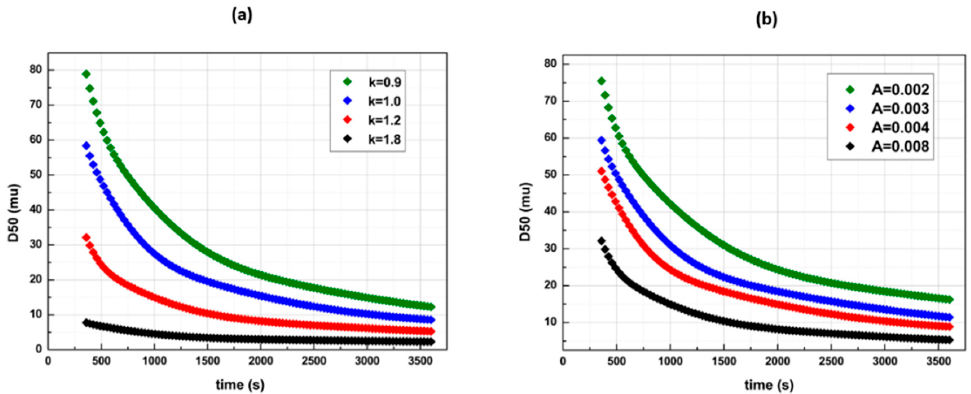
Figure 8. D50 time profiles with Kapur’s breakage function in various k and A parameter values with e = 6 ( a ) A = 0.008 and ( b ) k = 1.2.